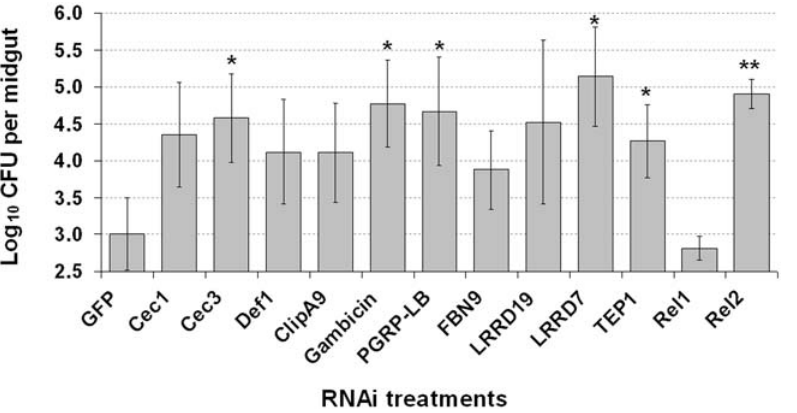
Figure 6. Immune gene-silencing influenced the bacterial loads of the mosquito midguts. Bars represent the mean values of total CFUs (log 10 transformed) from 10 midguts, and standard error bars are included. *, p , 0.05 ; **, p , 0.01 .